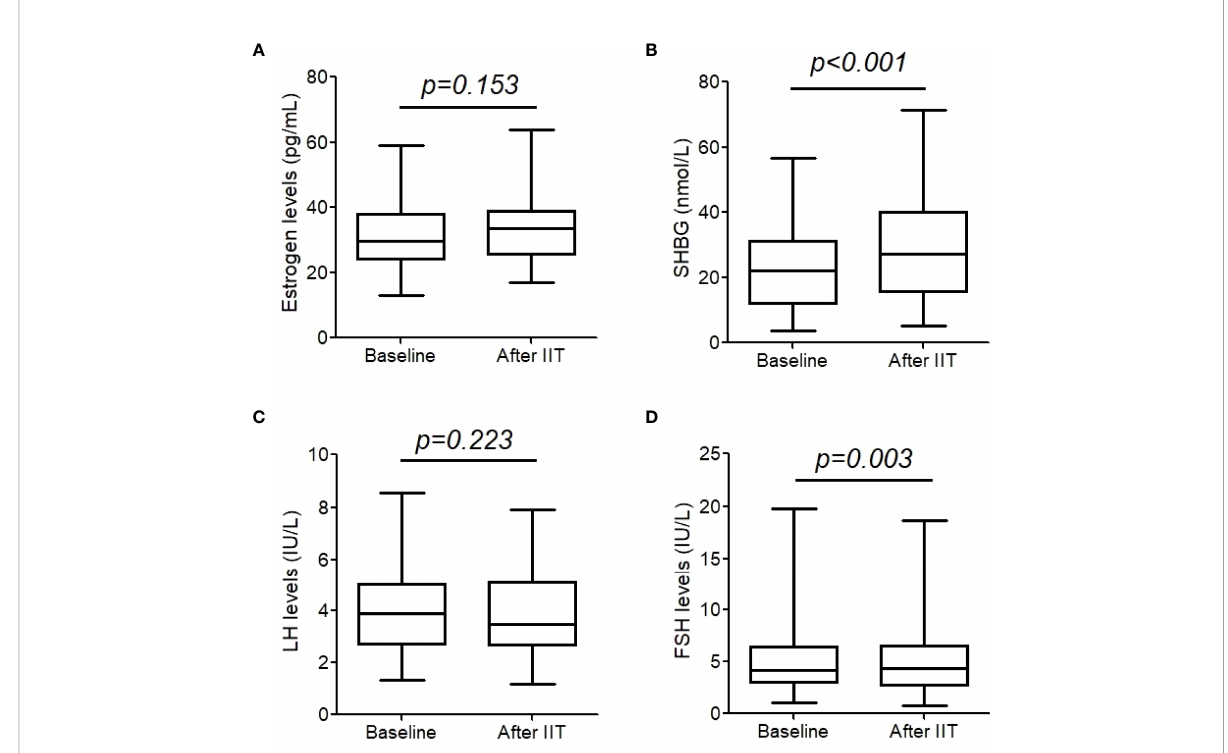
FIGURE 2 Estrogen (A) , sex hormone binding protein (SHBG) (B) , luteinizing hormone (LH) (C) , and follicle-stimulating hormone (FSH) (D) before and after intensive insulin therapy (IIT). These hormones were measure in 43 patients with T2DM. The whiskers of the box were showed as 5 – 95